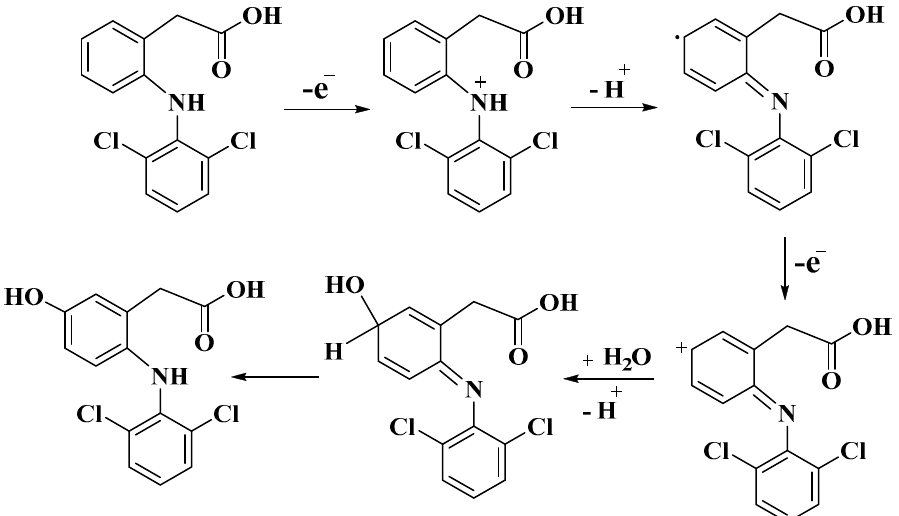
Figure 7. ( a ) LSVs of 0.5 DIC in 0.1 M at M-Chs NC/CPE at various scan rates from 0.01 V/s to 0.75 V/s. Insets: Dependence of the anodic peak current on Ʋ 0.5 , plot of log I p and E p versus log Ʋ ( b ) and ( c ), respectively.